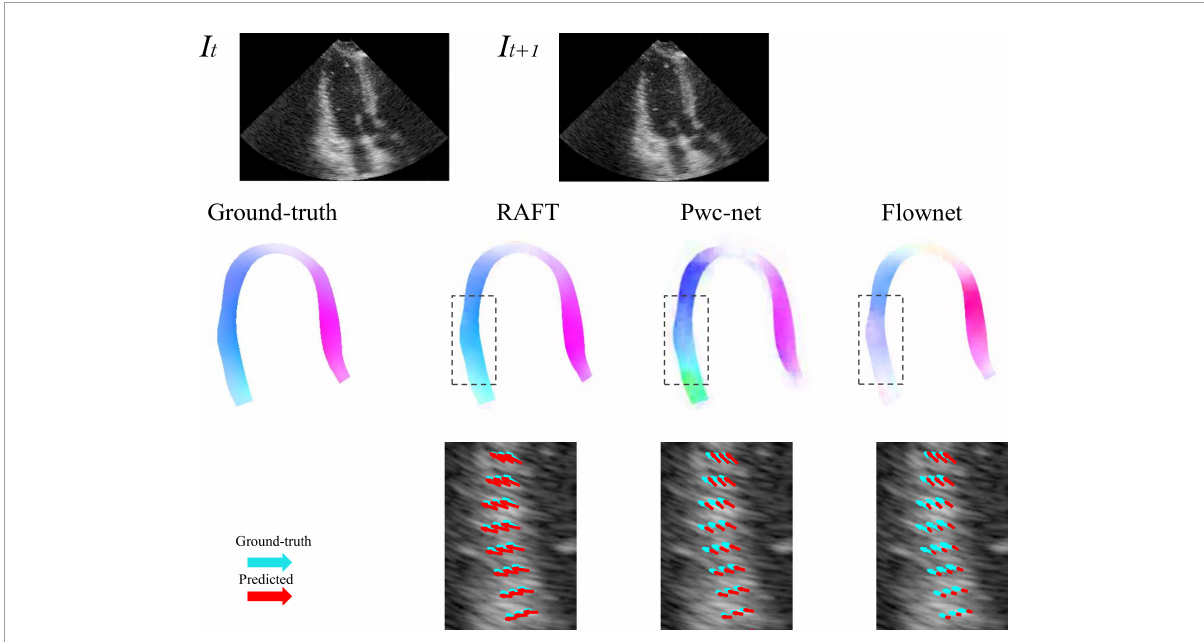
FIGURE5 Example of predicted optical flow patterns for the different models within the myocardium. The top row is the sequence of input to motion estimation networks. The middle row is the prediction of networks, represented by color coded with hue values, color and saturation indicate direction and magnitude, respectively. The bottom row shows the velocity vector comparison between ground truth and the different methods inside the locality as indicated by the dotted box in the ultrasound image. Light green arrows are ground truth, while red arrows are